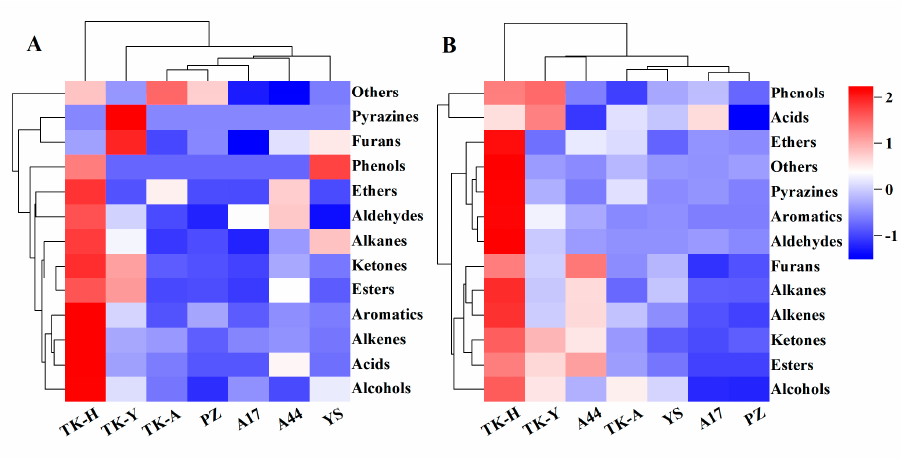
Figure 3. The cluster heatmap of the concentration of VCs grouped by chemical families: ( A ) was detected in Taraxacum leaves; ( B ) was detected in Taraxacum roots.